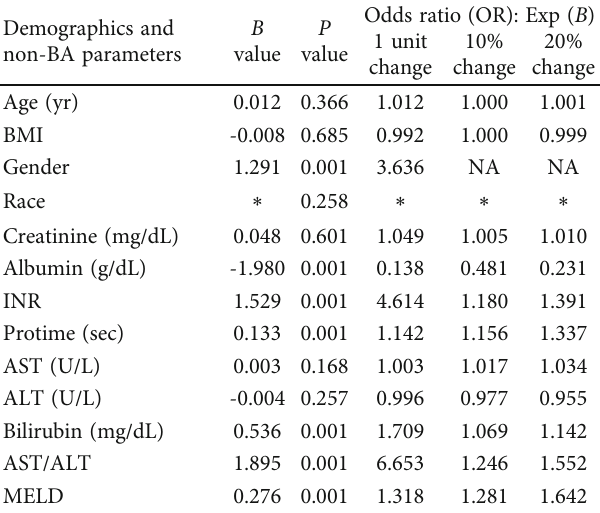
Table 5: Multivariate logistic regression analyses for ascites in the entire liver-patient population. (a) BALDC